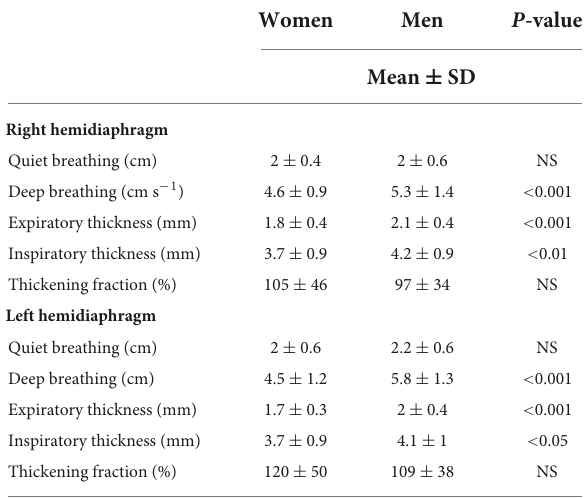
TABLE 1 Measurements of hemidiaphragm excursions and thicknesses in the studied